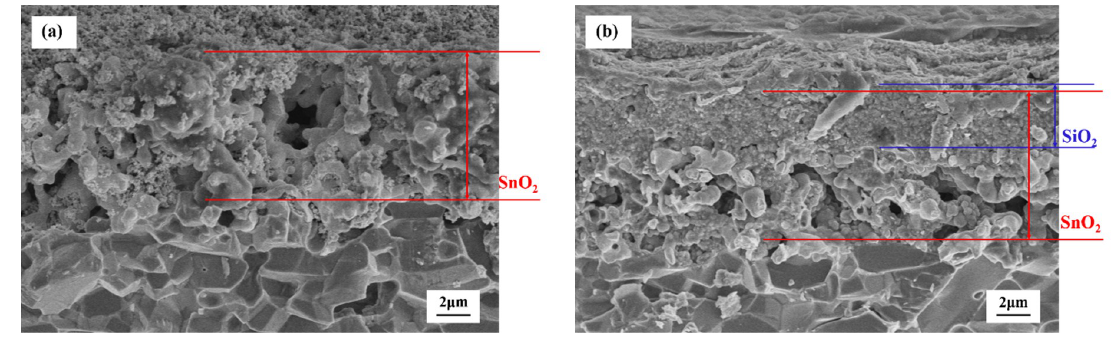
Figure 8. SEM micrographs of the cross-sections of the sensors: ( a ) untreated. ( b ) CVD treated at 500 ◦ C for 8 h.